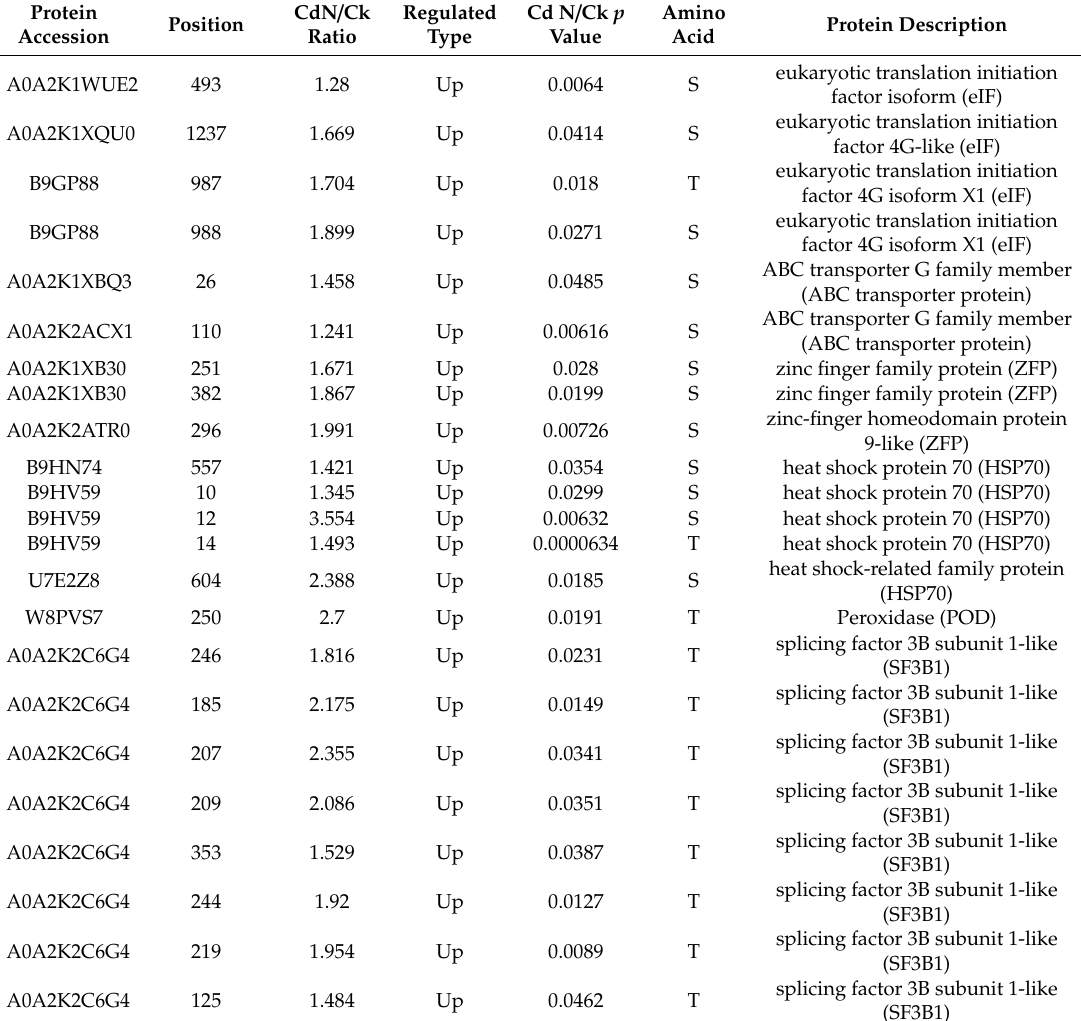
Table 6. List of partial phosphorylated proteins di ff erentially regulated by Cd + N in poplar plants. Protein